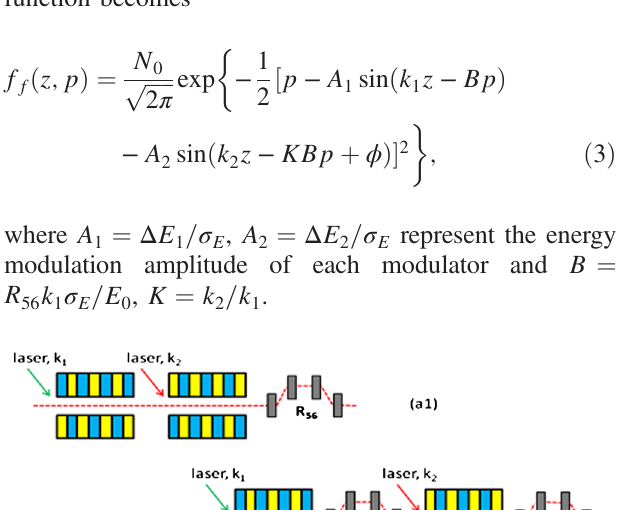
FIG. 2. Phase space evolution of the electron beam at various locations, where p is the dimensionless energy derivation in Eq. (2). (a) Exit of modulator 1; (b) exit of modulator 2; (c) exit of dispersion; and (d) final density